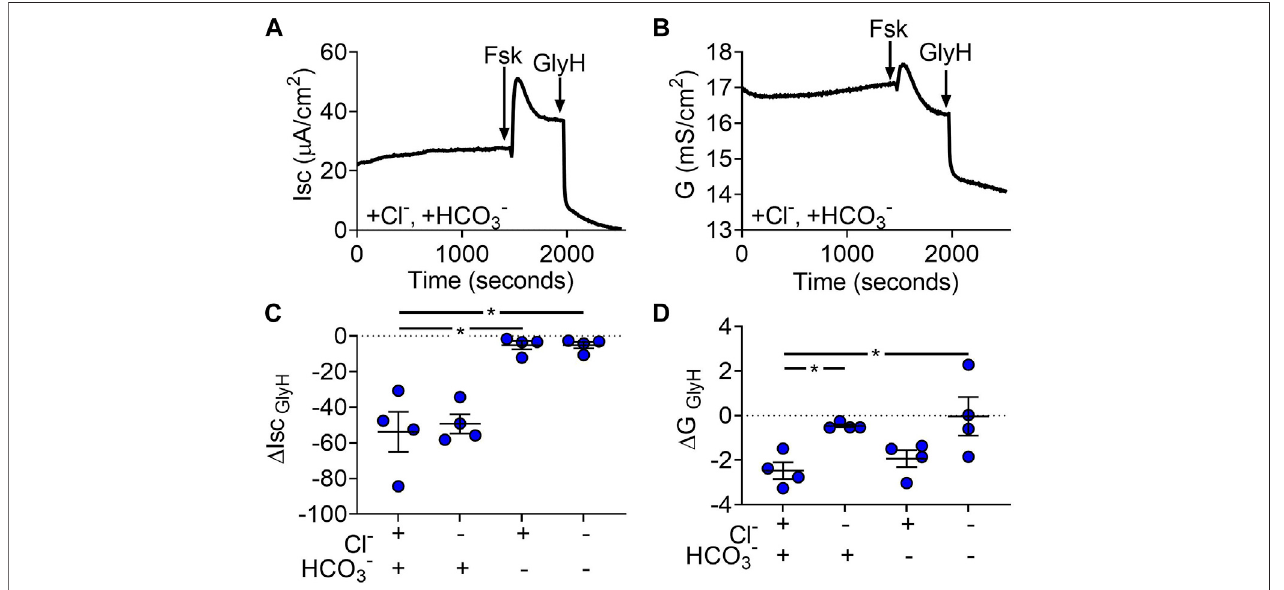
FIGURE 3 | Gallbladder organoid-derived monolayers transport Cl − and HCO 3 − . Representative (A) short-circuit current (Isc) and (B) conductance (G) traces after apical addition of forskolin ( fi nal concentration = 10 µM) and GlyH ( fi nal concentration = 100 µM) (C) Δ Isc and (D) Δ G response to apical GlyH addition. Each symbol represents a different donor. Bars represent mean ± SEM. * indicates p -value < 0.05; one-way ANOVA with Dunnett correction for multiple